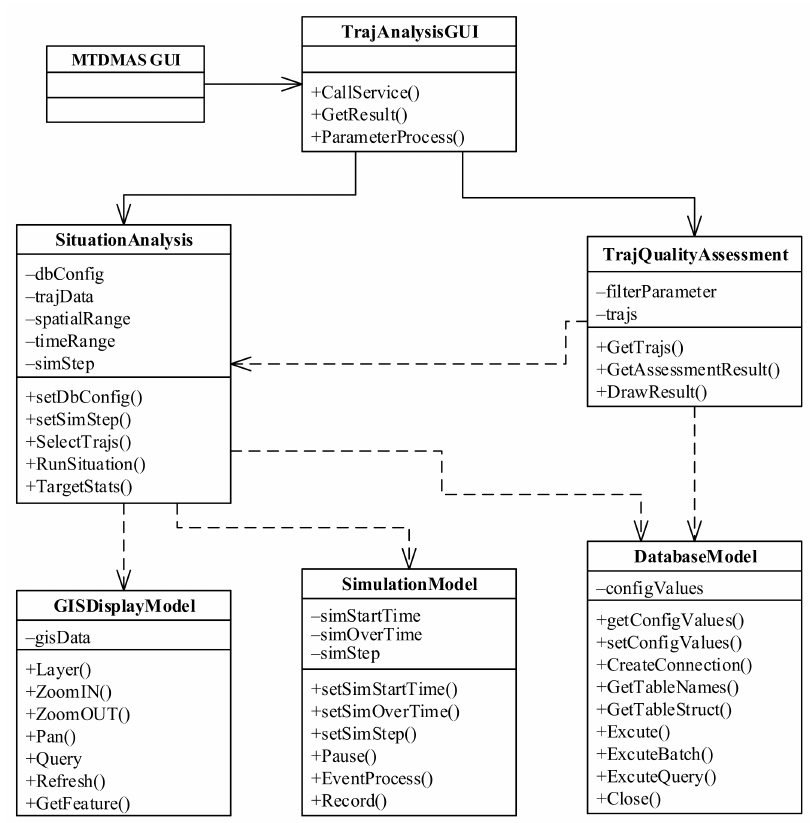
Figure 5. Class diagram of the trajectory analysis